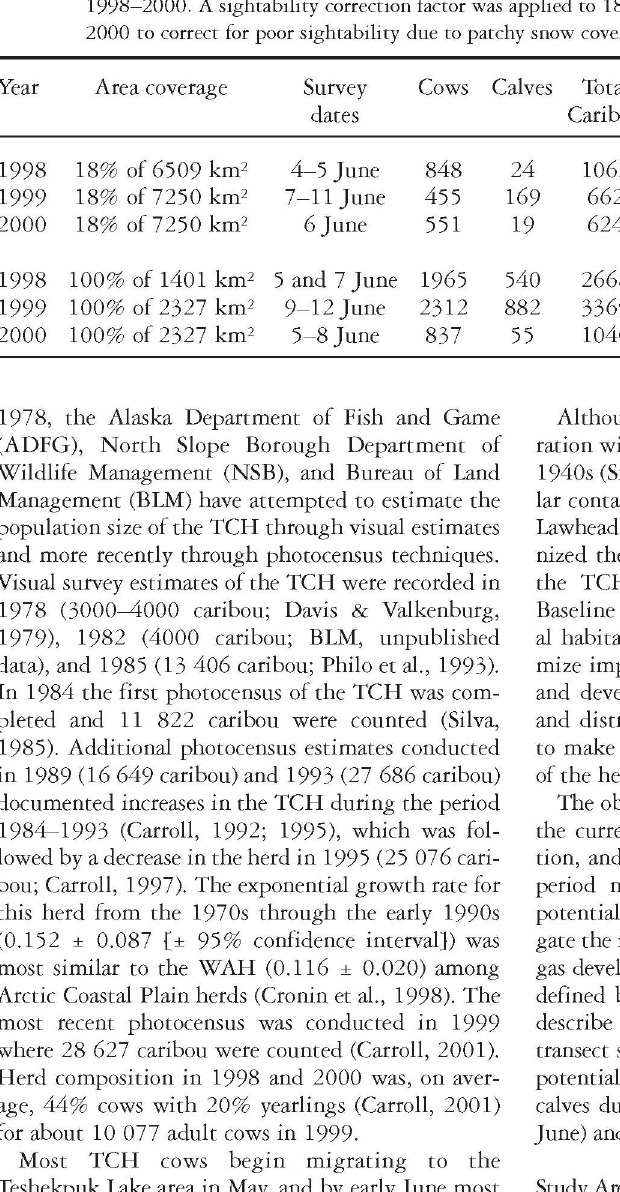
Table 1. Caribou number, density (caribou/km 2 ), and mean group size (± standard error of the mean) recorded on 6 sys tematic aerial strip-transect surveys during calving in the National Petroleum Reserve—Alaska, 4—12 June 1998—2000. A sightability correction factor was applied to 18% and 100% coverage surveys during 1999 and 2000 to correct for poor sightability due to patchy snow cover (Lawhead et al.,